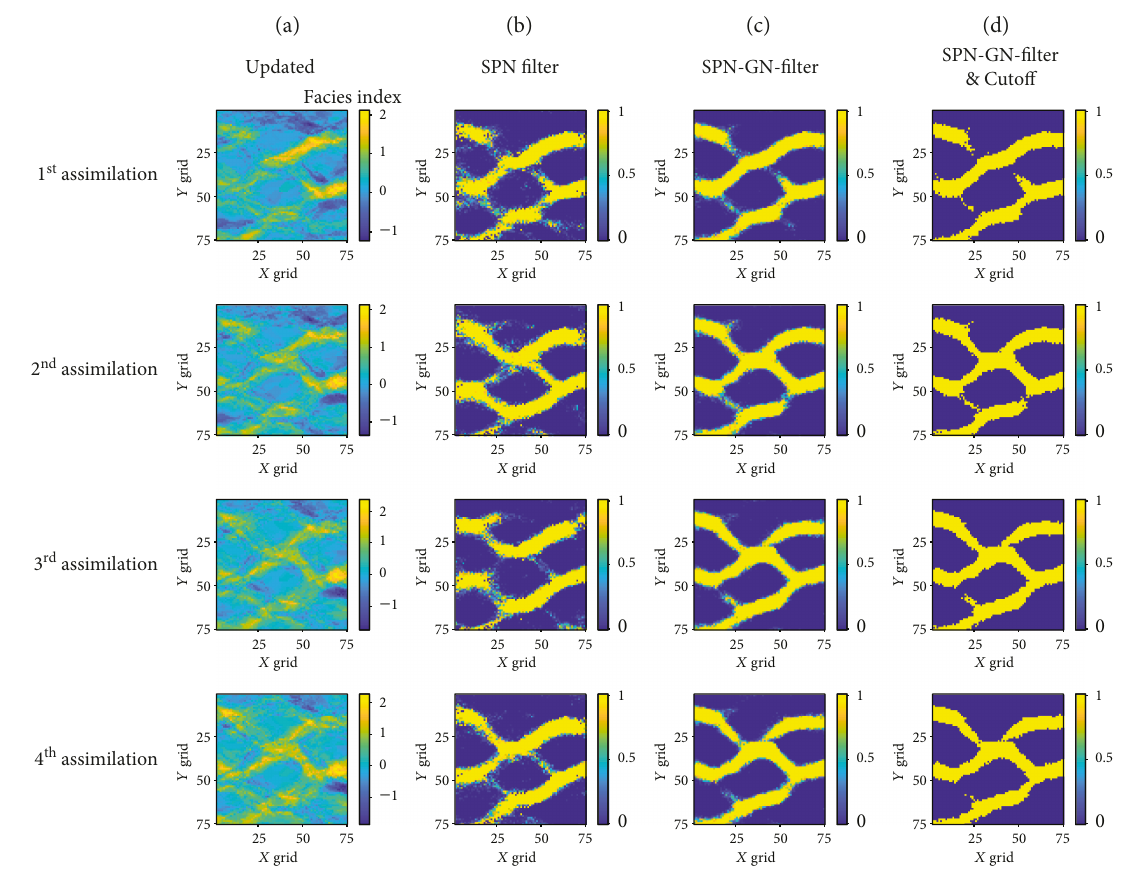
Figure 14: Updated facies distribution results of the fi rst ensemble member in every assimilation by the ES-MDA with